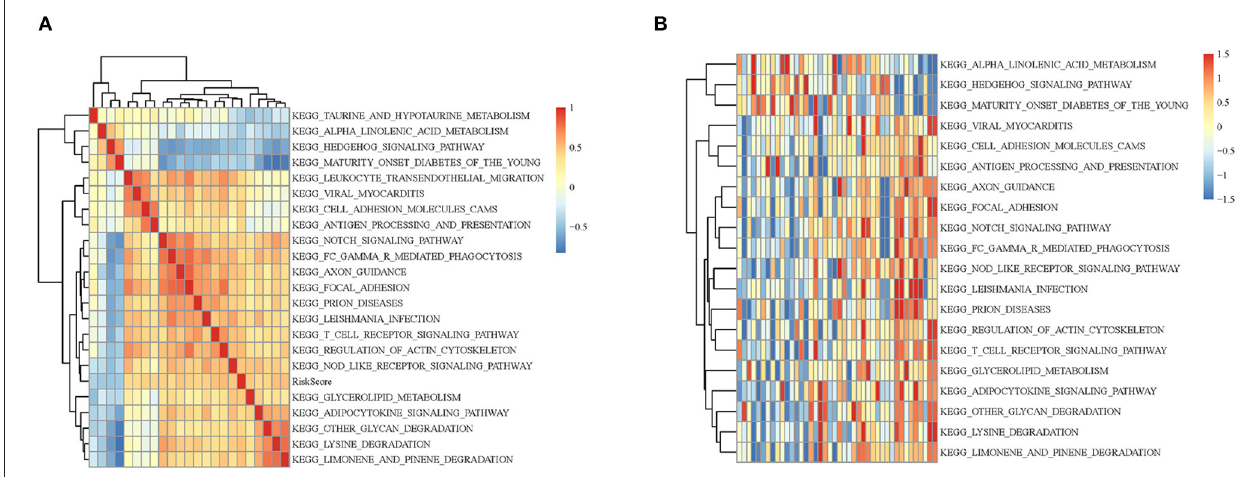
FIGURE 5 | (A) Clustering analysis between KEGG pathway whose RiskScore correlation > 0.4 and RiskScore correlation coefficients. (B) The relationship between the change of ssGSEA score and KEGG pathway RiskScore in each sample. The horizontal axis represents each sample, with risk scores rising from left to right.